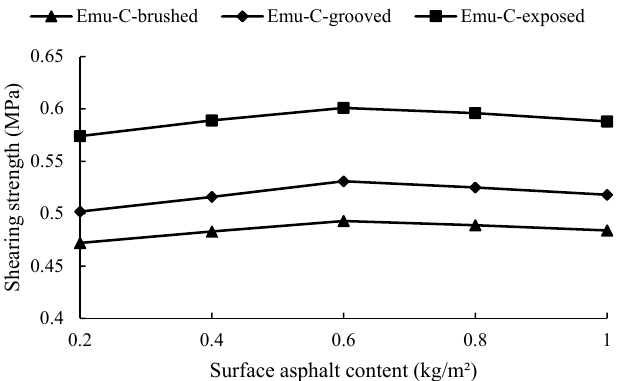
Figure 3. Shear strength of SBS-modified emulsified asphalt under different upper layer asphalt content.